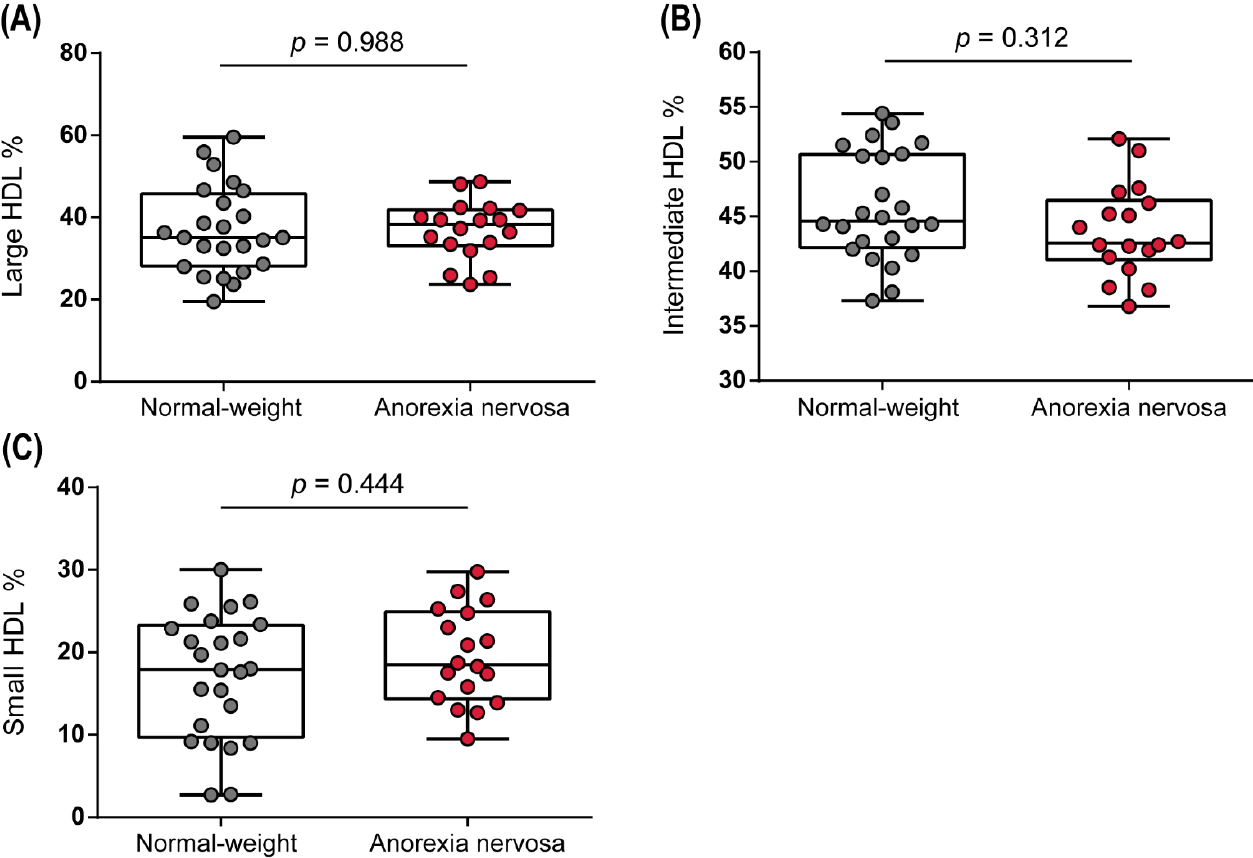
Figure 2. HDL subclass distribution of normal-weight and anorexia nervosa women. Subfractions of HDL were identified using the Lipoprint system. Subclasses were categorized into large ( A ), intermediate ( B ), and small HDL ( C ). Depending on the normal distribution of the data, t -test or Mann–Whitney U test was used to analyze differences between the two groups. Individual data are presented on top of boxplots, displaying median, interquartile range, as well as minimum and maximum values. Adjusted p -values according to Benjamini–Hochberg are displayed.